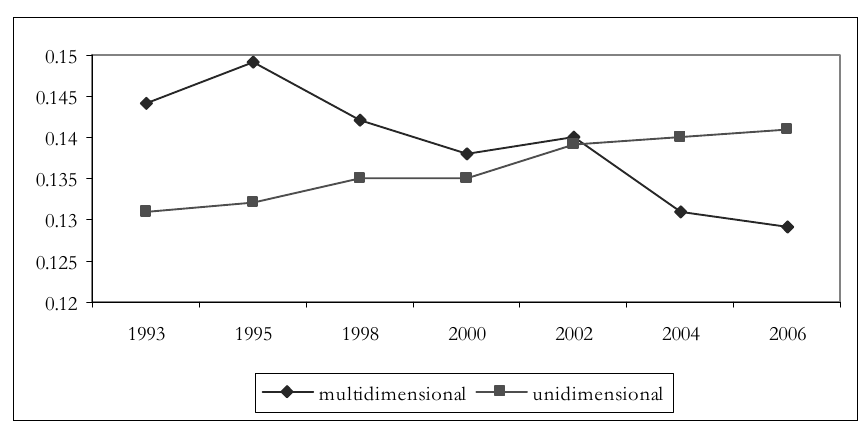
Figure 3 – Multidimensional fuzzy poverty ratio µ B and unidimensional fuzzy poverty ratio µ B ( X 1